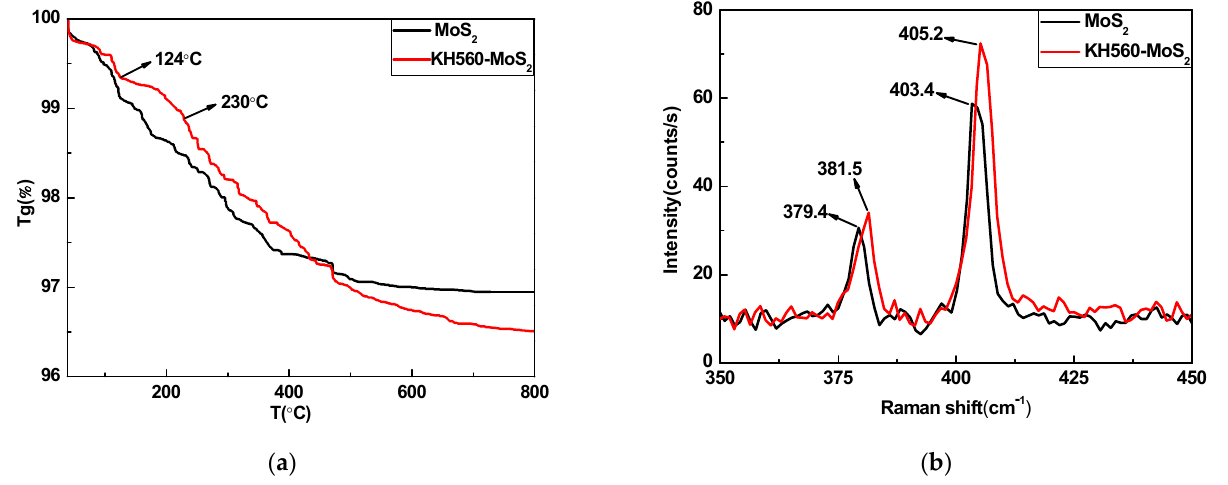
Figure 2. TGA curves ( a ) and Raman Spectroscopy ( b ) of MoS 2 and KH560-MoS 2 .